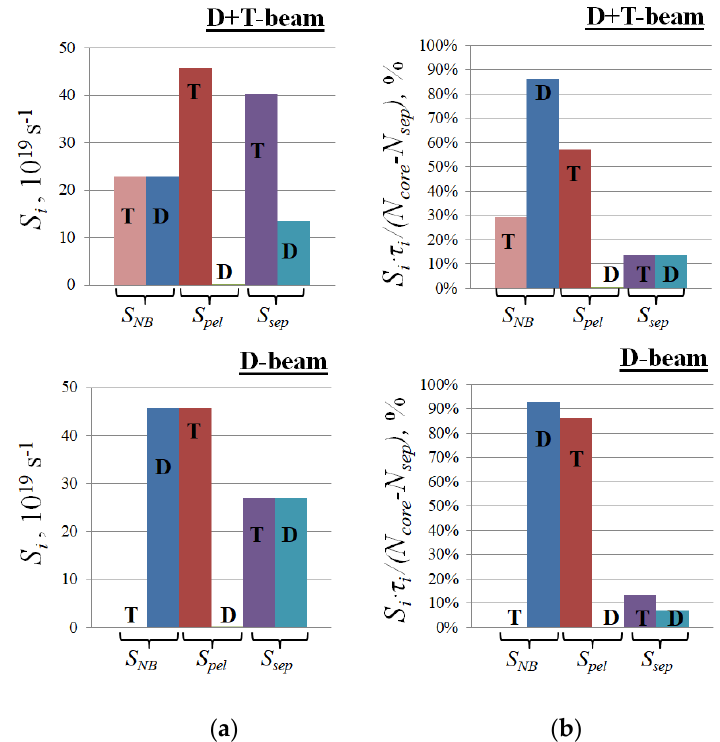
Figure 4. ( a ) Sources of deuterium and tritium in the plasma core, originating from the neutral beam S NB , pellet injection S pel , and divertor region S sep for the D + T (top) and D (bottom) beams. The absolute values of the particle flux sources are given. n e = 8.5 × 10 19 m − 3 , D/ χ e = 0.4. For the D + T and D beams, f coreT = 0.75 and 0.5, respectively. ( b ) Fractions of particles from different sources with allowance for their lifetimes.